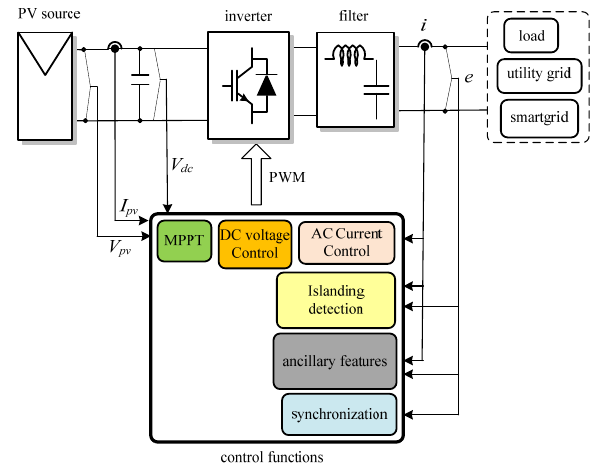
Figure 1. Single-stage photovoltaic systems (PVSs) control functions.